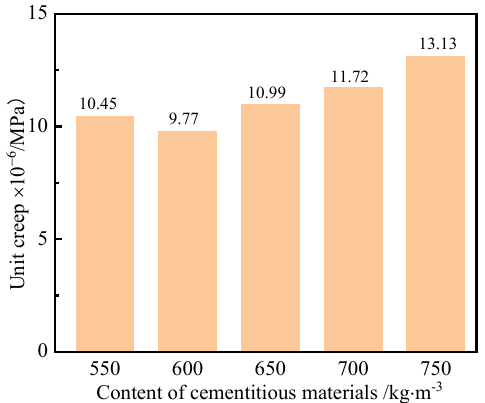
Figure 9. Unit creep of the UHPC cured for 90 d with different contents of cementitious materials.